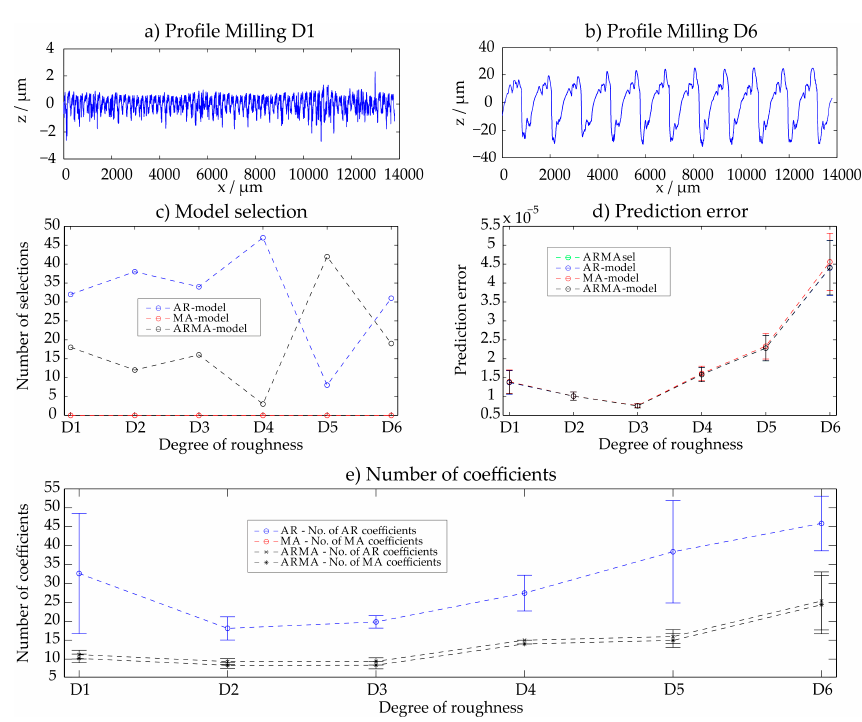
Figure A2. Milling—results of the ARMAsel approach.